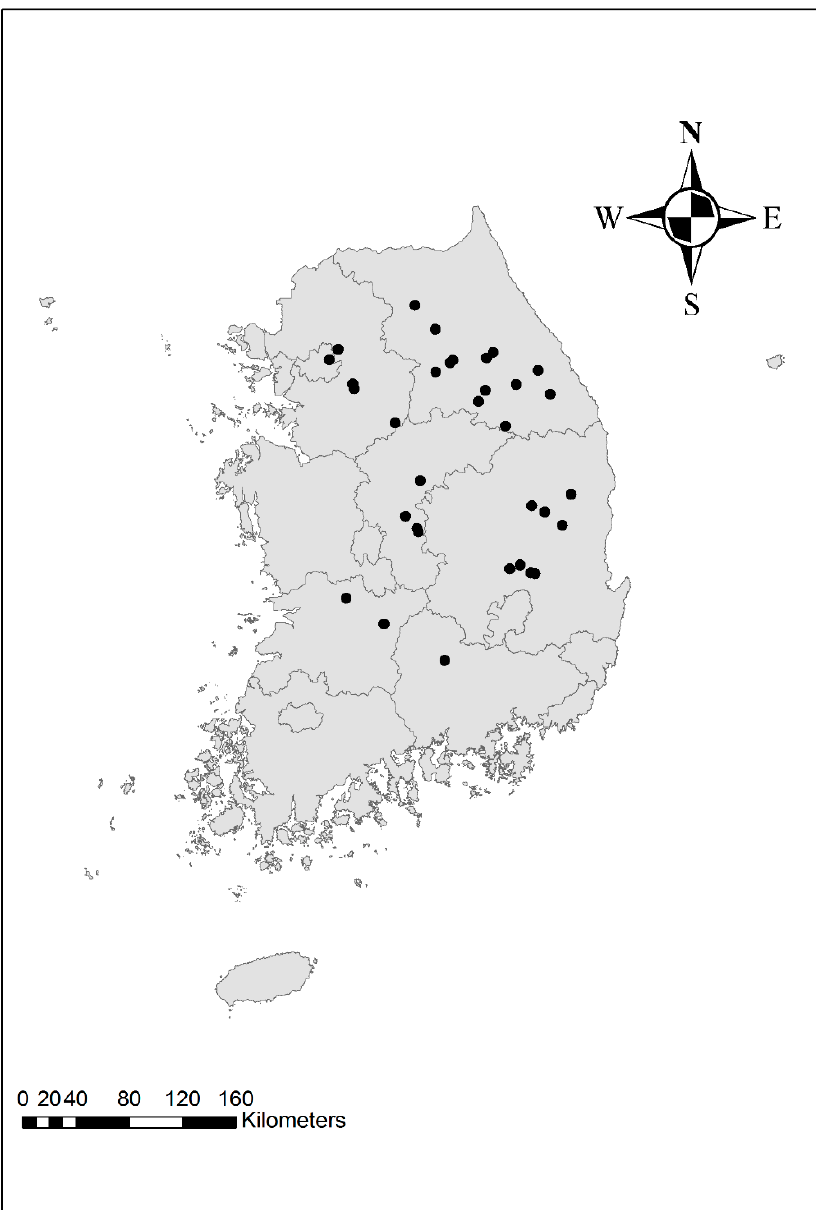
Figure 1. The 33 river basins in South Korea that were used in the study. The black points indicate the outlet of each river basin, which includes a streamflow station.